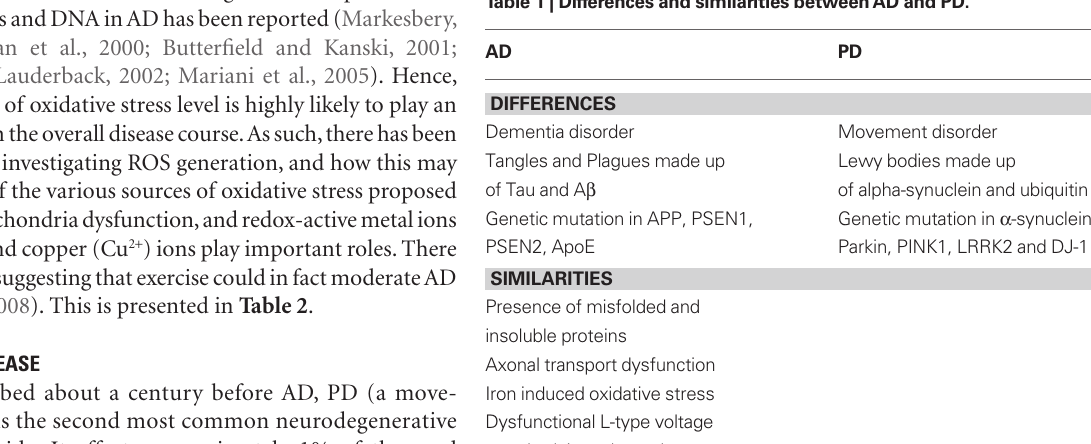
Table 1 | Differences and similarities between AD and